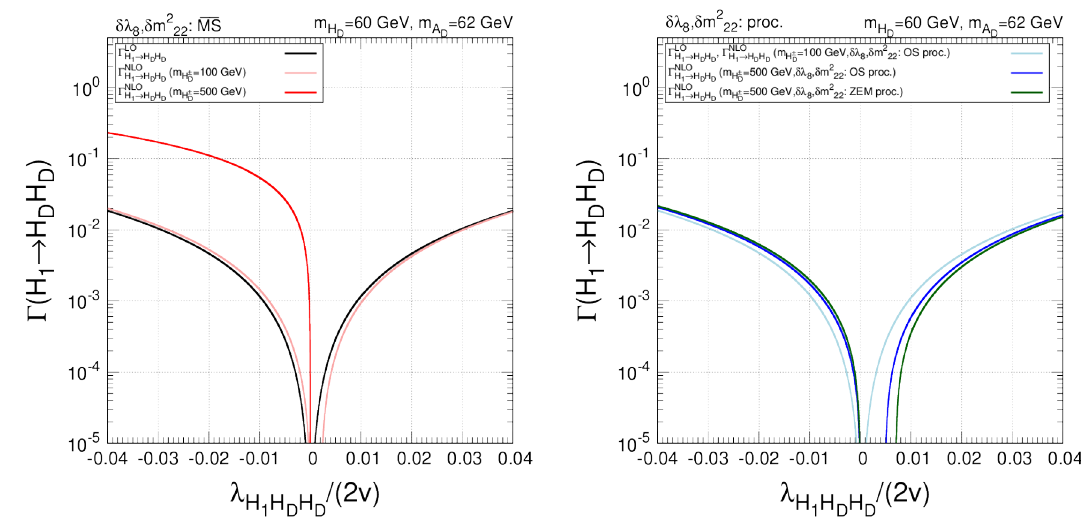
Figure 1 . Decay width H 1 → H D H D at LO and NLO as a function of the tree-level coupling for m = 60 GeV and m = 62 GeV, and for two different values of m λ H H D A D 1 H D H D and 500 GeV. The variable m 2 is scanned in a range such that the DM direct detection constraints 22 hold. Other input parameters are fixed to the values given in eqs. (5.1), (5.2) and (5.3). The left panel shows the results for the MS scheme, while the right panel presents results for the two process-dependent